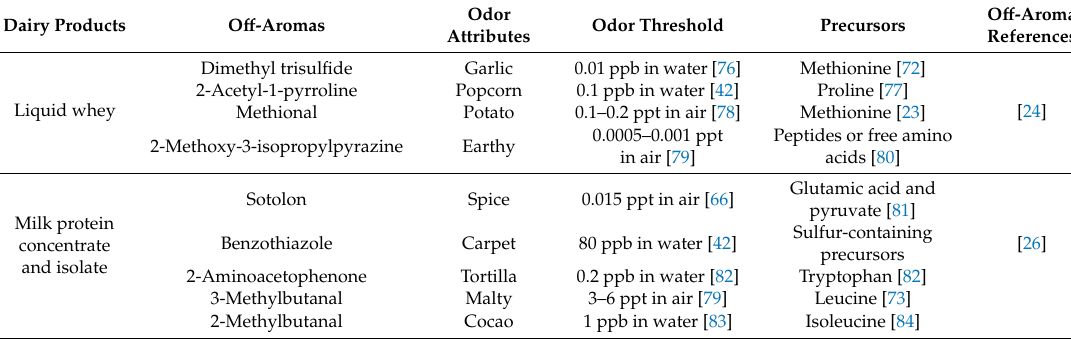
Table 3. O ff -aromas generated from the Maillard reaction pathway in dairy